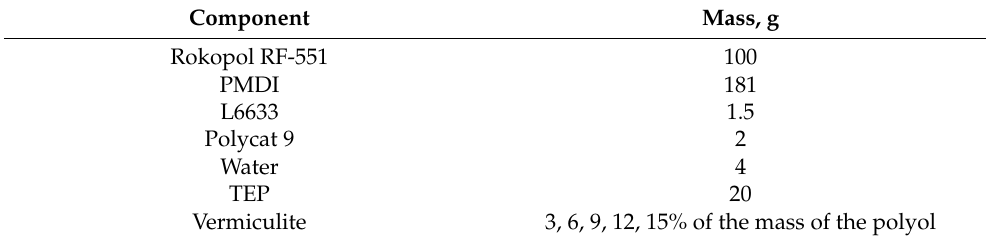
Table 1. The formulation of the reference polyurethane